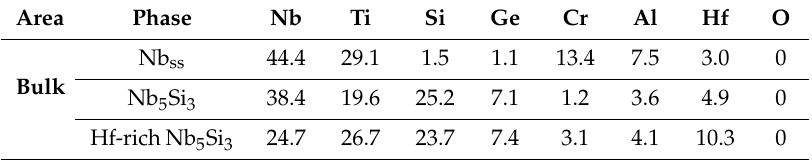
Table 6. The composition (at.%) of the constituent phases in the bulk in the oxidised alloy ZF9.